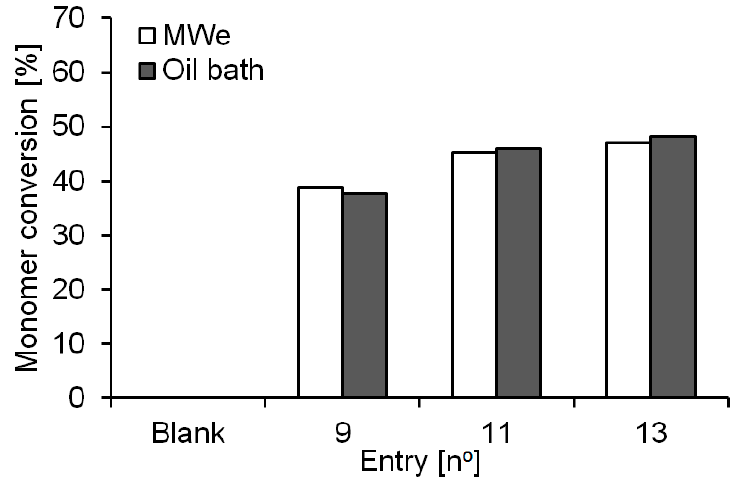
Figure 4. Monomers conversion overview from the reactions conducted in organic solvents catalyzed by Novozym ® 435 at 30 °C (entry 9) and 38 °C (entries 11 and 13). Conversions were calculated from 1 H-NMR spectra of the crude reaction mixture.